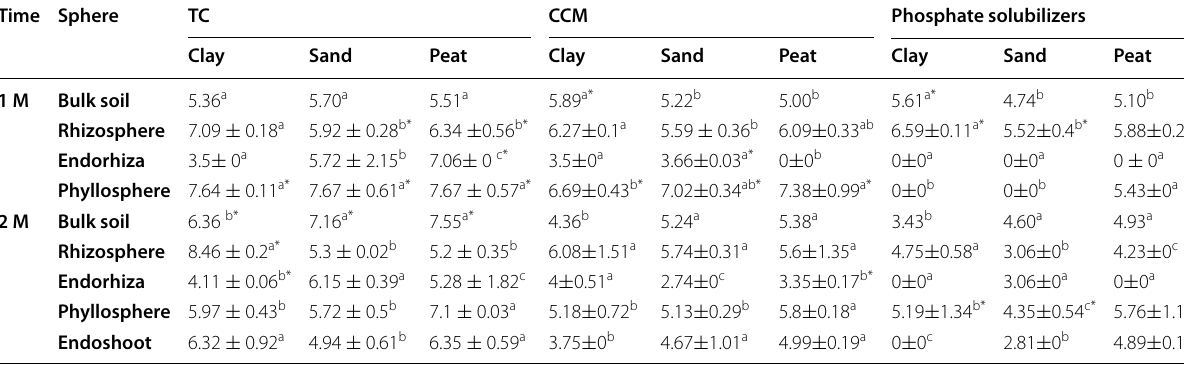
Table 2 Average CFU g ‑1 Log for total CFUs obtained from each plant sphere and soil type 10